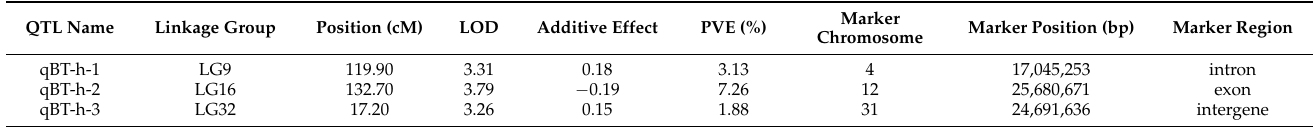
Table 4. Information on body thickness-related QTLs in Yellow River carp at 5–9 months after hatching.